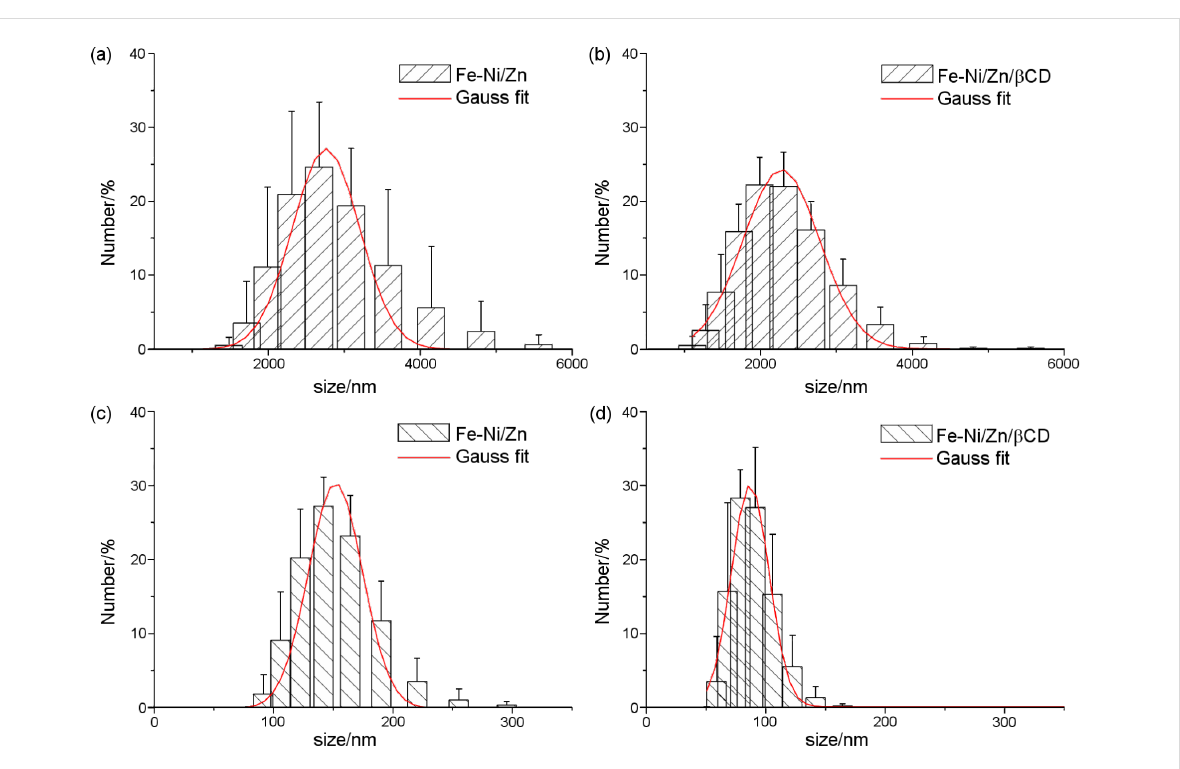
Figure 3: DLS measurements for before (a) and (b) and after (c) and (d) the sonication